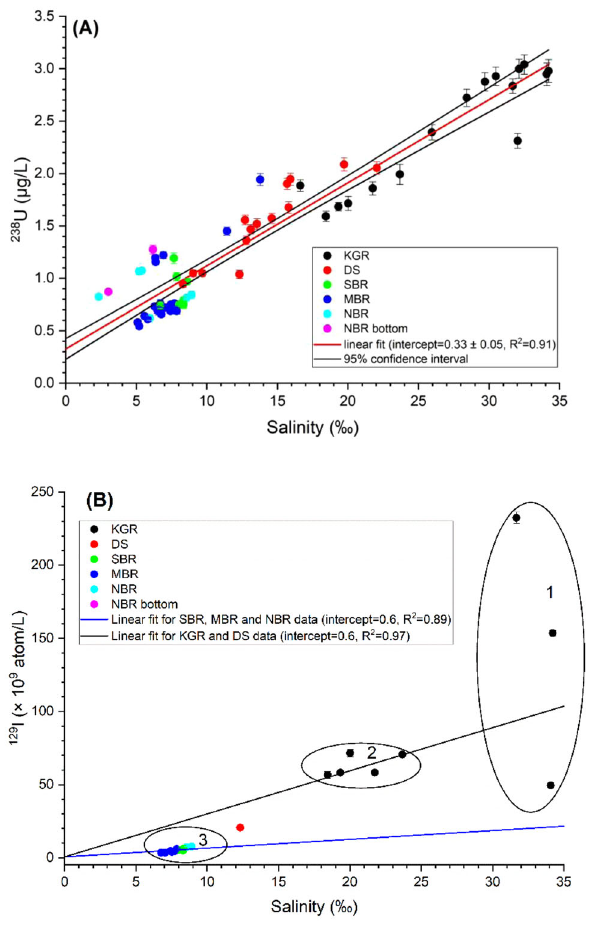
Fig. 4 Variations of 236 U/ 238 U and 236 U/ 129 I with salinity. 236 U/ 238 U atomic ratio ( A ) and 236 U/ 129 I atomic ratios ( B ) vs. salinity. KGR Kattegat – Skagerrak region including the Kattegat, Skagerrak and Danish west coast nearby the North Sea, DS Danish Straits including the Belt Seas and the Sound, SBR South Baltic Sea region including Arkona Basin, Borholm Basin, and South Baltic Proper, MBR Middle Baltic Sea region including Northern Baltic Proper, Western Gotland Basin, Eastern Gotland Basin, and Gulf of Riga, NBR North Baltic Sea region including Archipelago and Åland Sea, Bothnian Sea, and Bothnian Bay, L (blue solid line) the best- fi t binary mixing line between the North Sea water and a freshwater end member with salinity = 0, 238 U = 0.4 µ g/l, 236 U/ 238 U atomic ratio = (6.79±0.75) × 10 − 8 , and 236 U = (6.87± 0.76)× 10 7 atom/l, L1 (black dashed line) the binary mixing line between the North Sea water and an assumed freshwater end member containing no 236 U (salinity = 0, 238 U = 0.4 µ g/l, 236 U/ 238 U atomic ratio = 0 and 236 U = 0, L2 (red dashed line) the binary mixing line between the North Sea water and the best- fi t freshwater end member with salinity = 0, 238 U = 0.4 µ g /L, 236 U = (3.56±0.39)× 10 7 atom/l, and 236 U/ 238 U atomic ratio = (3.52± 0.39)× 10 − 8 . The area marked in yellow represents the estimated excess mass of 236 U in the Baltic Sea ( X 236 ), average salinity (cid:1) S = 7.36 ‰ . Uncertainties are expanded uncertainties using a coverage factor of k = 236 U source (Supplementary Fig. 2). The distribution pattern is compatible with the introduction of additional riverine 236 U input from the north Baltic region, which has most river runoff. Nevertheless, it is challenging to de fi ne the 236 U/ 238 U ratio of the riverine input to the Baltic because a component of global fallout may still be present in runoff from the land surface. The 236 U/ 238 U and 236 U/ 129 I ratios cannot be used to determine the extent to which the excess 236 U is from global fallout or an